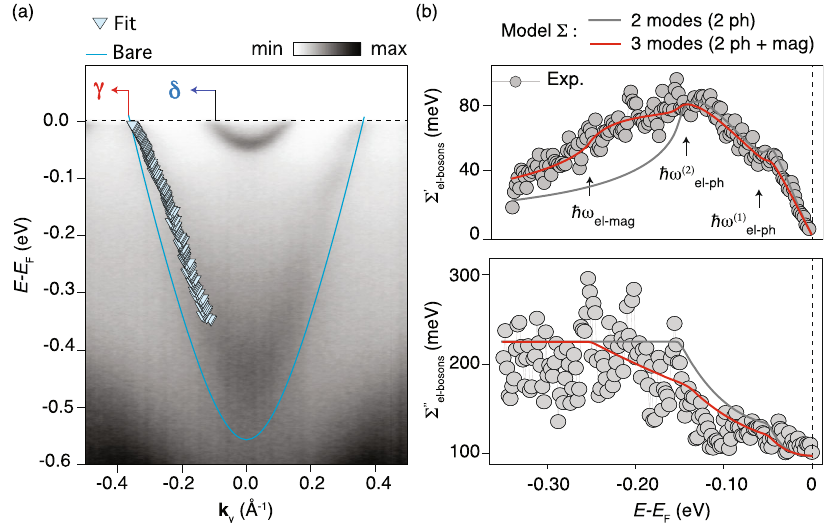
Fig. 2 Electron – boson coupling. a Electronic structure measurements ( h ν = 90 eV, measured along the Γ -K ̄ direction) showing the γ and δ bands. The non-interacting, bare band, dispersion is taken as a k ⋅ p band, set to match the Fermi wavevectors of the experimental dispersions as described in the Methods. b The real and imaginary parts of the electron – boson self energy extracted from the data and from a Migdal- Eliashberg calculation as described in the Methods. A two-phonon model (grey lines) fails to describe the experimentally determined self energy, while a three-mode model (red line, with coupling to two phonons plus a magnon mode) is in much better agreement. The arrows in ( b ) show the characteristic mode energies. The real and imaginary parts of the self-energy retain causality through Kramers-Kronig